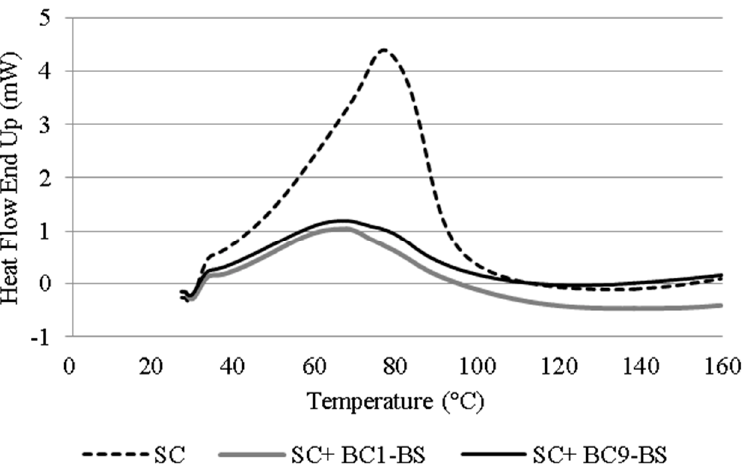
Figure 6. DSC curves of the SC obtained from porcine skin treated with BC1-BS and BC9-BS at a concentration below their